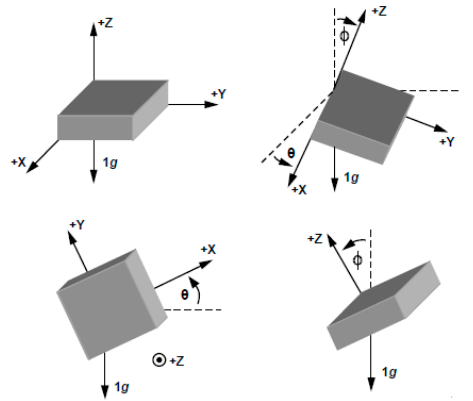
Figure 5. Triple-axis accelerometer to measure angles [35].